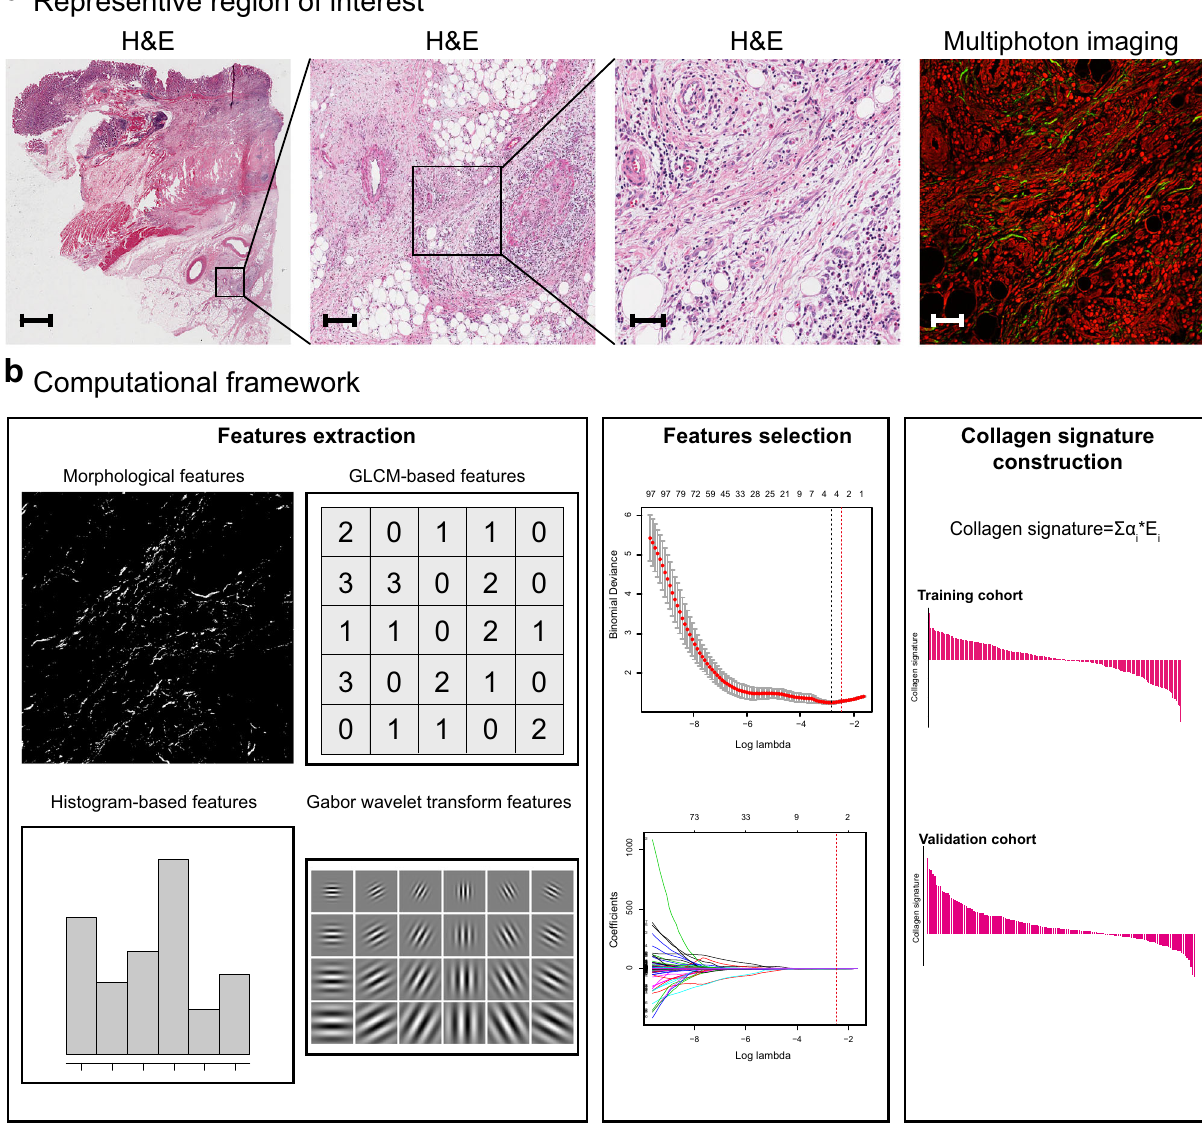
Fig. 1 Construction framework of the collagen signature. a Selection of the region of interest by comparing H&E staining and multiphoton imaging. The samples of all enroled 343 patients are used, and fi ve regions of interest with a fi eld of view of 500 × 500 μ m per sample within the invasive region of the gastric serosa are randomly selected for multiphoton imaging. Scale bars: 1500 μ m, 150 μ m, 50 μ m and 50 μ m, respectively. b A total of 146 collagen features for each enroled patient are extracted from multiphoton images, and predictive collagen features are selected using LASSO regression in the training cohort, and the collagen signature is constructed. The collagen signature of the validation cohort is calculated from the collagen signature calculation formula obtained in the training cohort. GLCM, grey-level co-occurrence matrix; H&E, hematoxylin and eosin; LASSO, least absolute shrinkage and selection